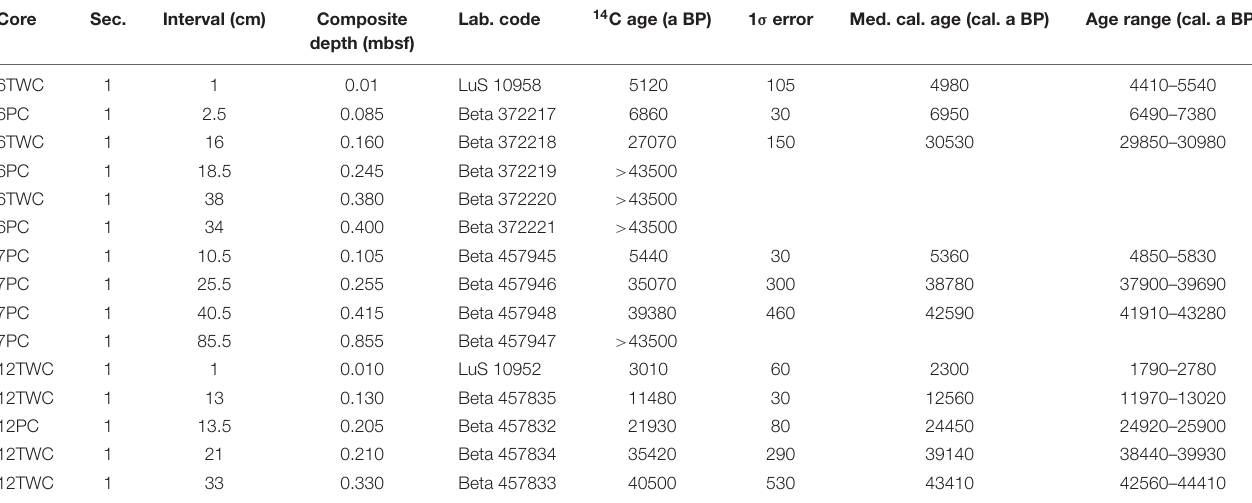
TABLE 2 | Radiocarbon dating results from LOMROG12